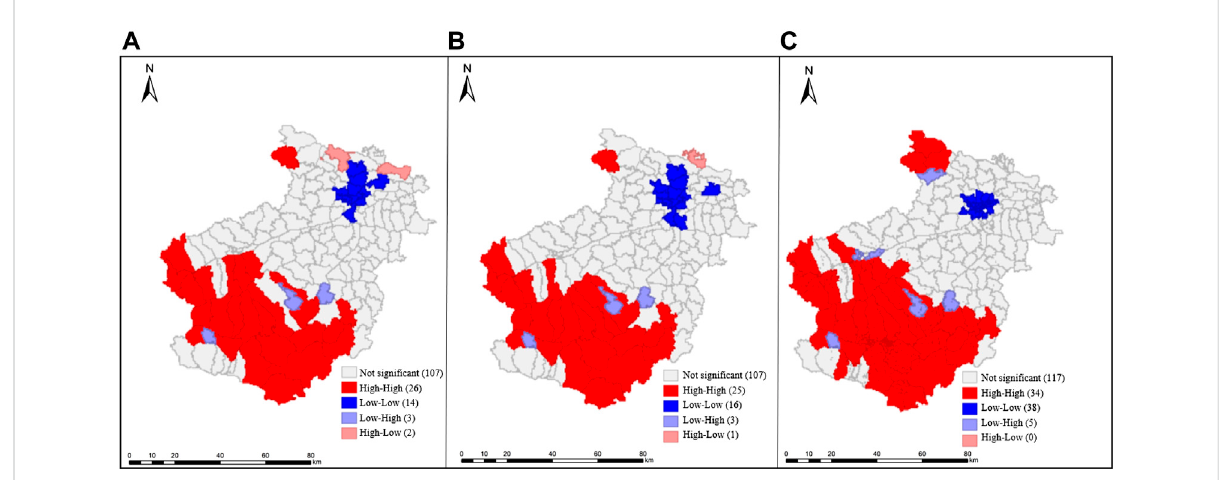
FIGURE 7 Local indicator of spatial association (LISA) maps of ESV in the Luoyang City area in (A) 2010; (B) 2015; and (C) 2019.